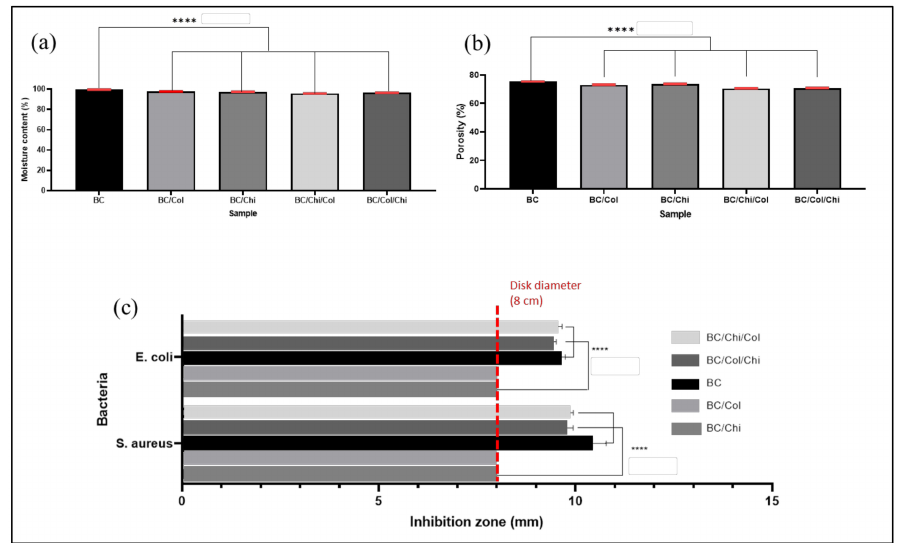
Figure 7. ( a ) Moisture content, ( b ) porosity, and ( c ) antibacterial activity of BC, BC / Col, BC / Chi, BC / Chi / Col, and BC / Col / Chi ( n = 4) (**** p <